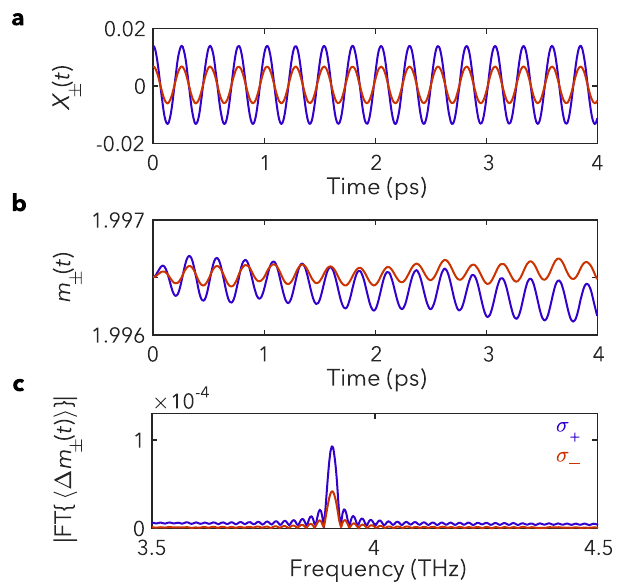
Fig. 4 Spin-phonon dynamic simulations. Simulations at T < T c , for σ þ (blue) and σ (cid:3) (red) pump polarizations, which show a coherent oscillations t ð Þ , b coherent oscillations in the in the average phonon displacement, X ± t ð Þ , driven through spin-phonon coupling, and c the magnetization, m ± Fourier transform of the magnetization dynamics, displaying a distinct peak at the phonon